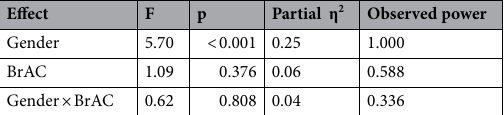
Table 4. Multivariate tests for backward